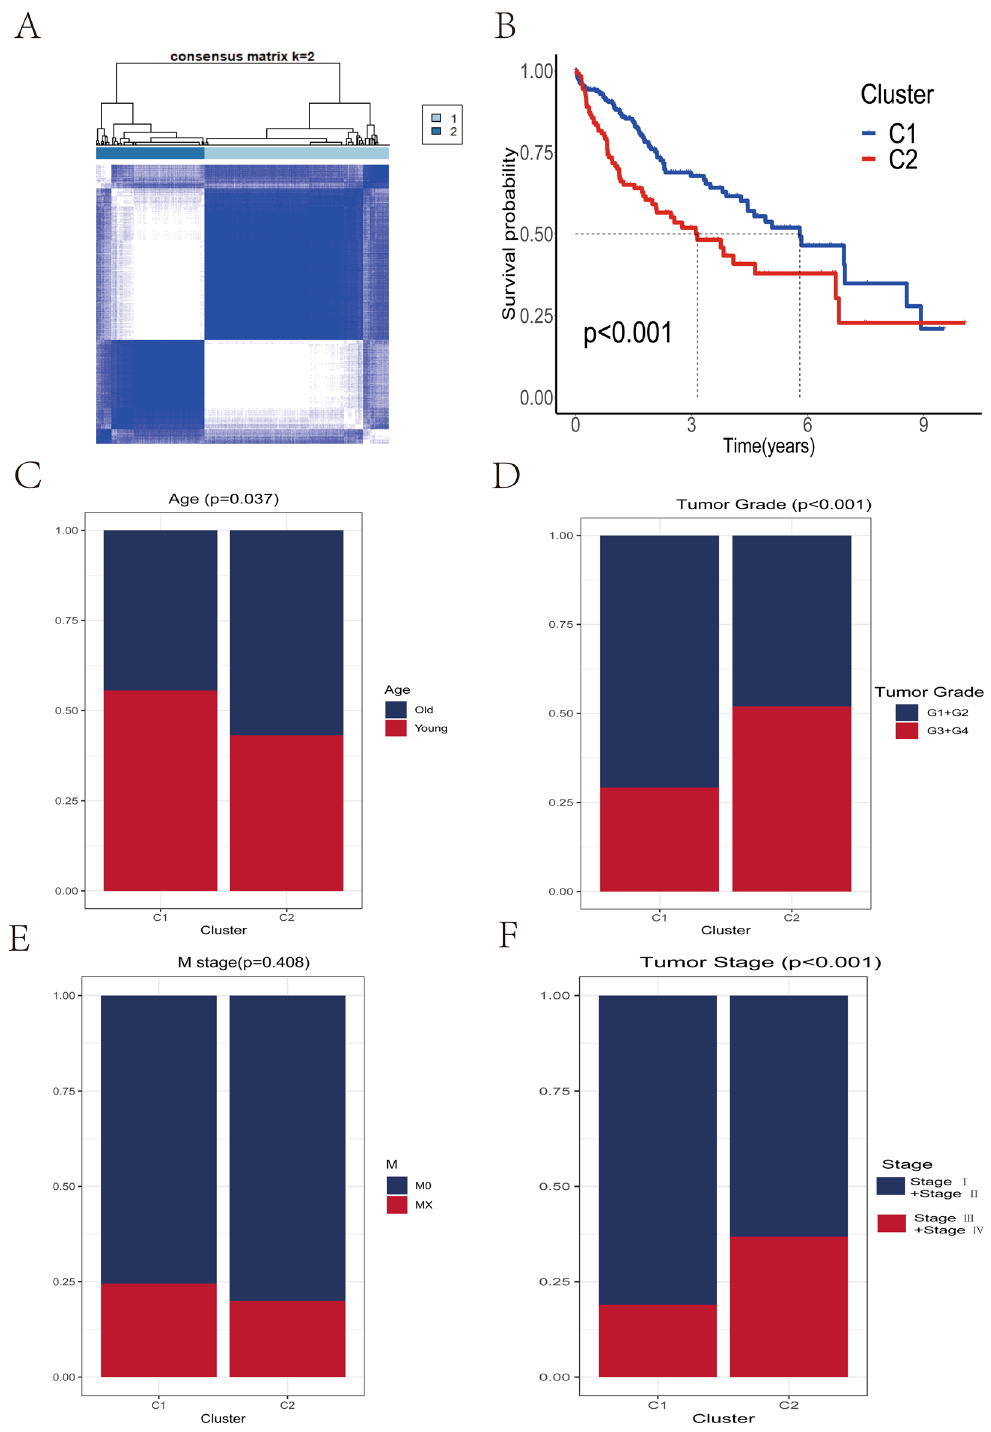
Figure 1. Clustering of HCC patients in the training set and the relationship between the results of each cluster and clinical characteristics and survival. ( A ) The 365 HCC patients in the training set were clustered into Cluster1 (C1) and Cluster2 (C2) based on the expression levels of 279 cellular senescence genes. ( B ) Kaplan– Meier survival analysis showed a significant difference in overall survival time between C1 and C2. ( C – F ) The relationship between different clusters and clinical features, including age ( C ), tumor grade ( D ), M stage ( E ) and tumor stage ( F